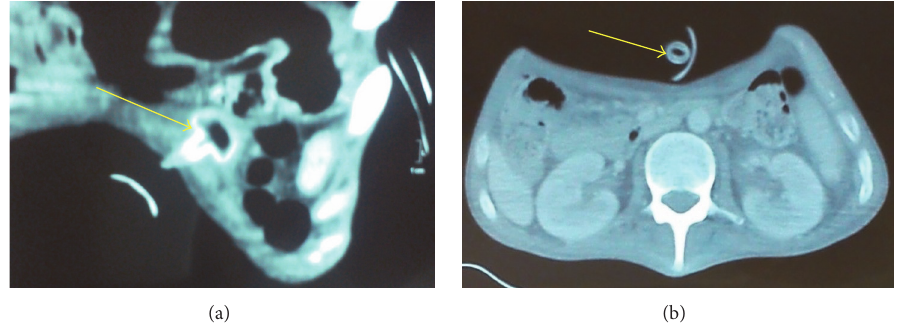
Figure1:Abdominalcomputedtomographyrevealedtheinternalbumperburiedinthegastricwall(yellowarrows)butwithoutsubcutaneous tissue or intra-abdominal